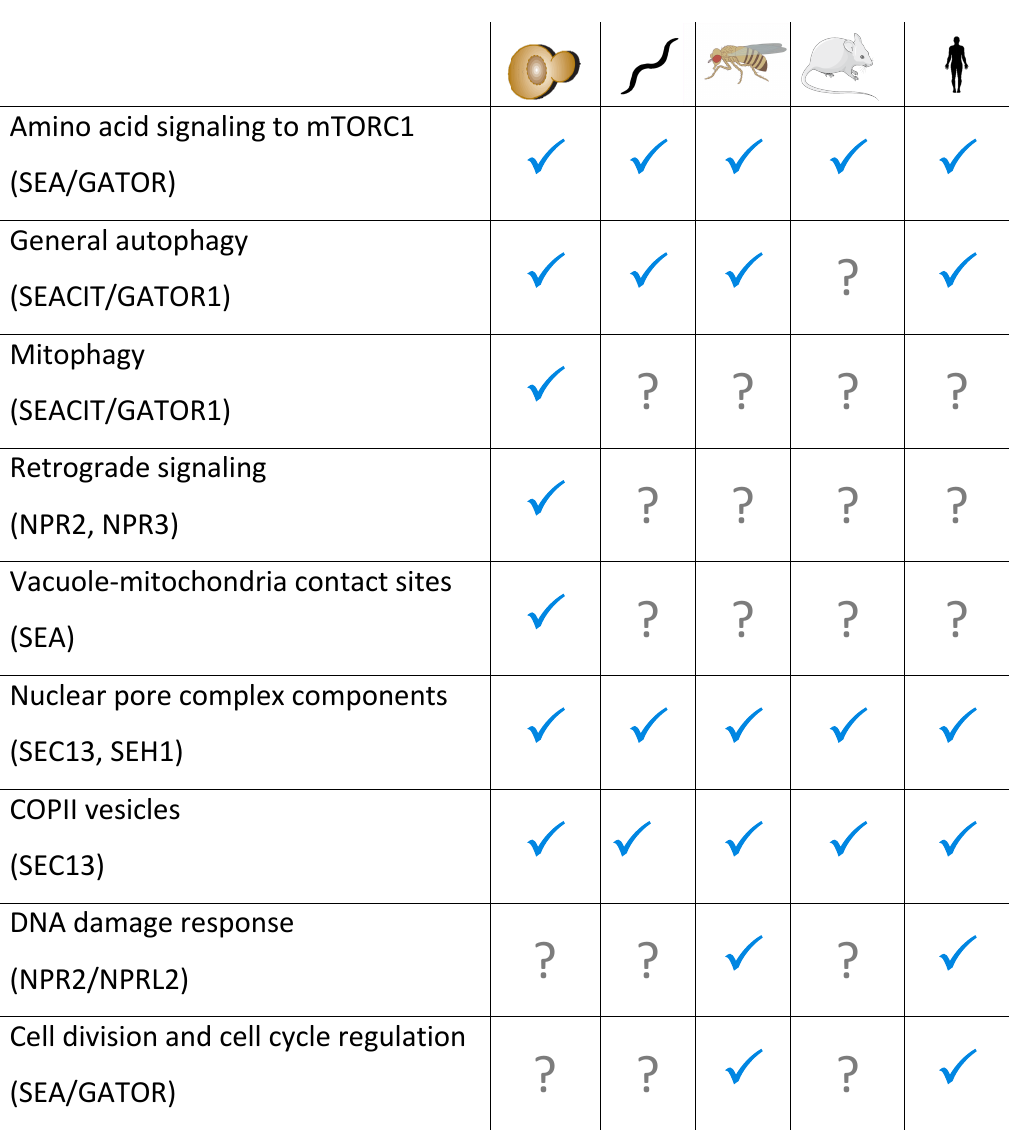
Figure 5. Multiple functions of the SEA/GATOR complex. The deletion of SEA/GATOR components affects mitochondria functions. The total abundance of SEA proteins is increased during respiratory growth and decreased upon nitrogen starvation, sea2 deletion impairs respiration capacity in S. cerevisiae [147]. npr2 ∆ cells have defective mitochondrial-housed metabolic pathways, such as synthesis of amino acids, and an impaired tricarboxylic acid (TCA) cycle activity. npr2- deficient cells showed decreased pools of nitrogen-containing intermediates of the TCA cycle and nucleotides. Yet, npr2 ∆ yeast use TCA cycle intermediates for replenishment of biosynthetic pathways to sustain the hypermetabolic state due to mTORC1 constant activation, suggesting a role of SEACIT in the regulation of cataplerotic reactions of the TCA cycle depending on the